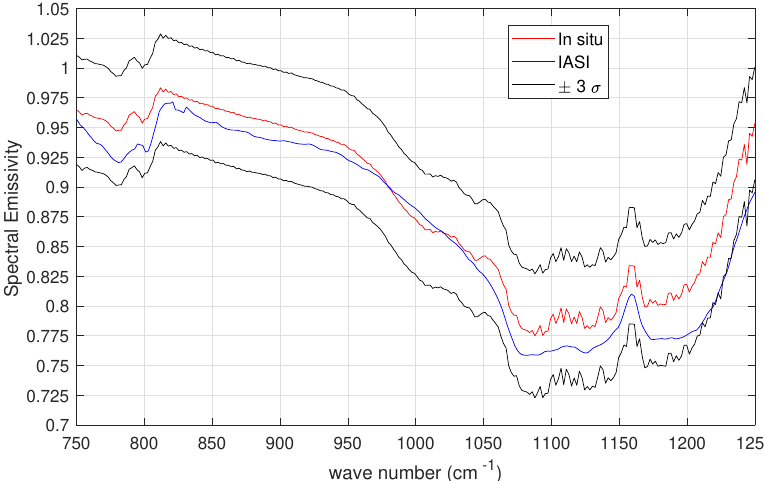
Figure 16. IASI vs. in situ emissivity for the best collocated IASI soundings. The ± 3 σ interval is the variability (standard deviation) of in situ